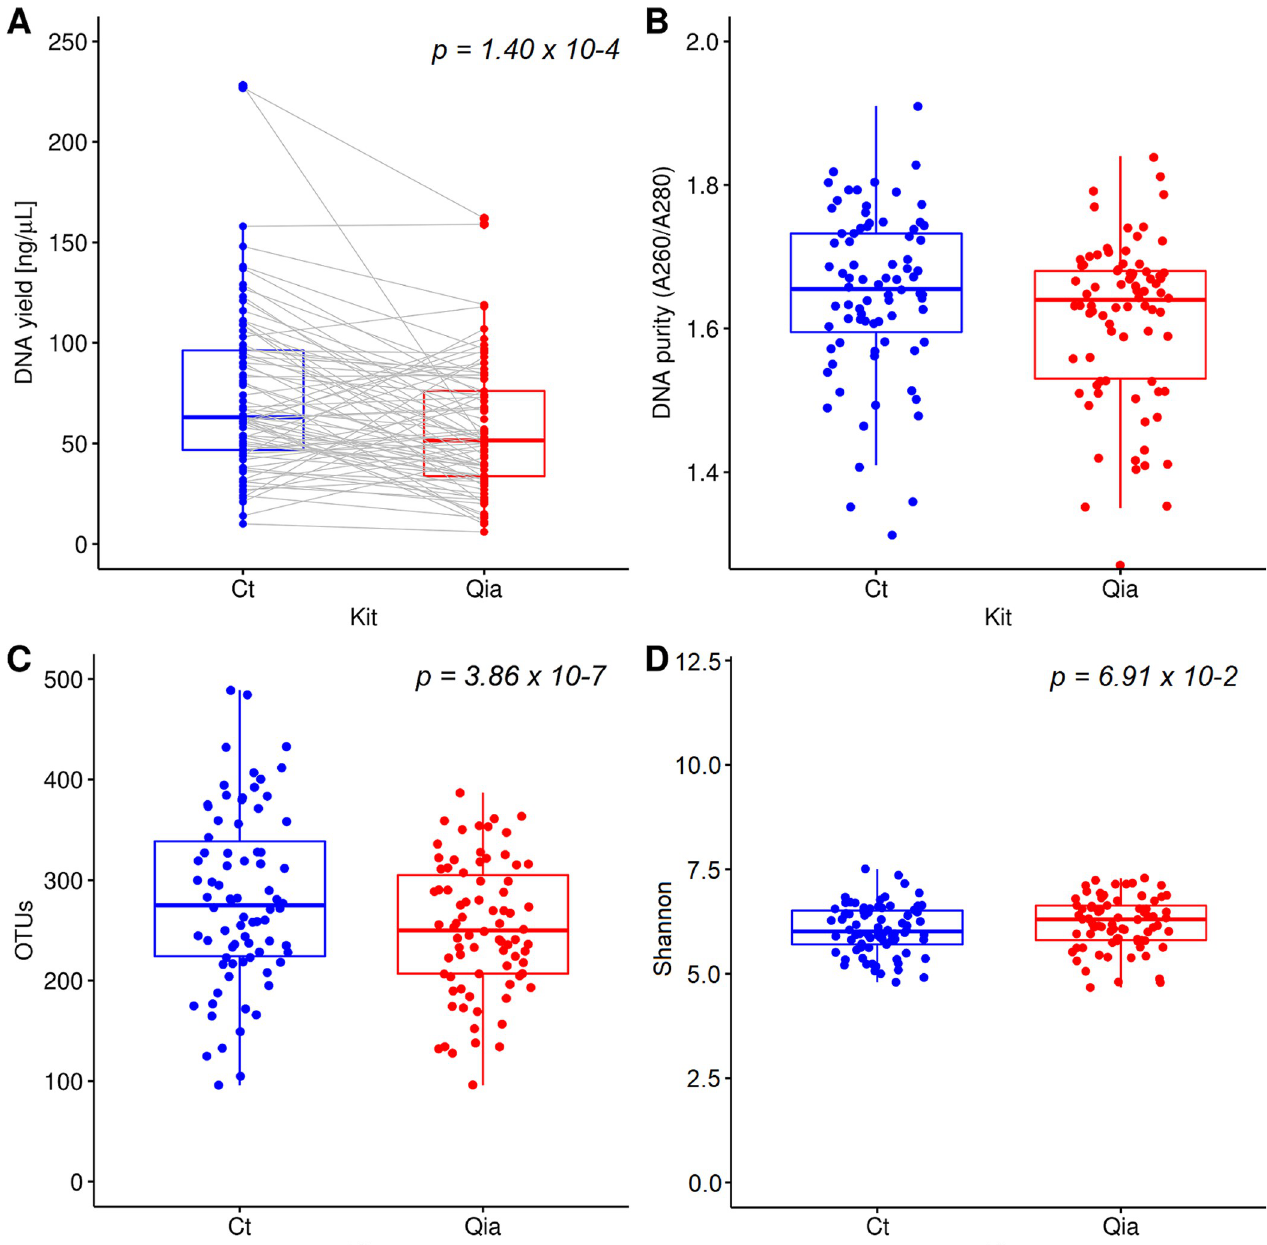
Fig 1. Comparison of DNA quality and bacterial diversity using two DNA isolation kits (Ct and Qia). A. DNA yield. The gray lines represent the same sample pair. B. DNA purity. C. OTUs D. Chao1 index.